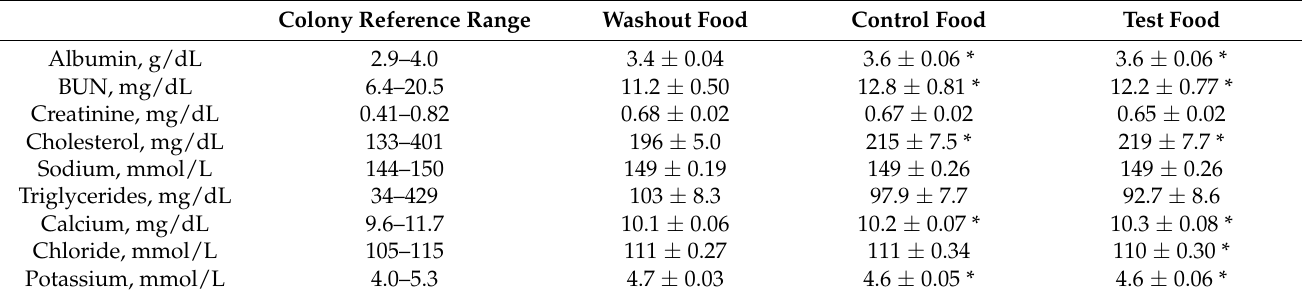
Table 3. Blood chemistry parameters following consumption of the control and test